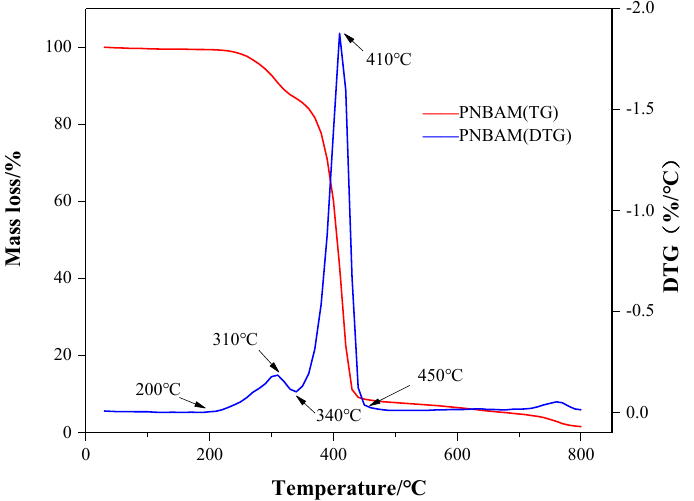
Figure 3. TG/DTG for PNBAM.